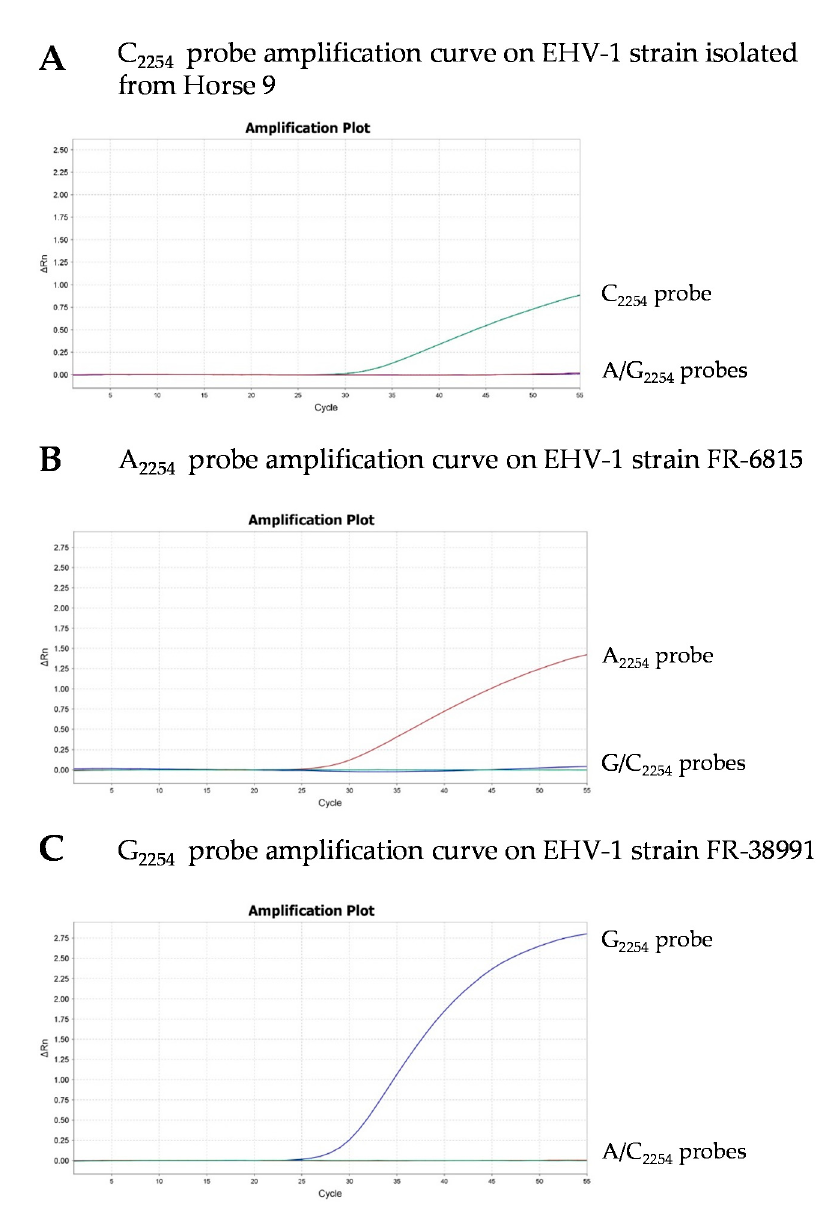
Figure 2. Real-time PCR amplification curves using C 2254 probe (green curve) and both A 2254 (red curve) and G 2254 (blue curve) probes on a 145 bp fragment of the ORF30 for the typing of an EHV-1-positive sample from the premises described in Section 3.1 (C 2254 ) ( A ), EHV-1 strains FR-6815 (A 2254 ) ( B ) and FR-38991 (G 2254 ) ( C ). Simplex amplification curve (C 2254 ) and multiplex amplification curves (A / G 2254 ) are combined in each graph.